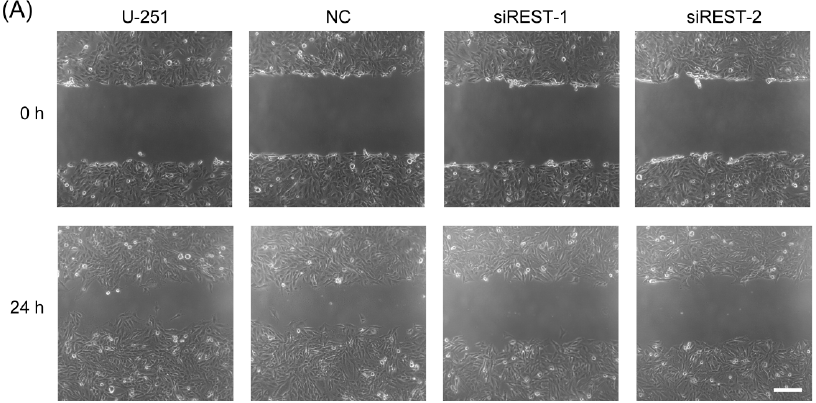
Figure 7. Cont. Figure 7.